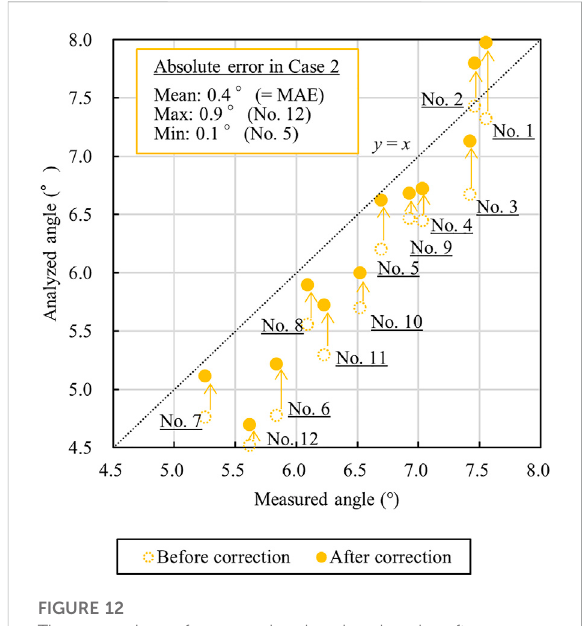
FIGURE 12 The comparison of measured and analyzed angles after image correction in Case